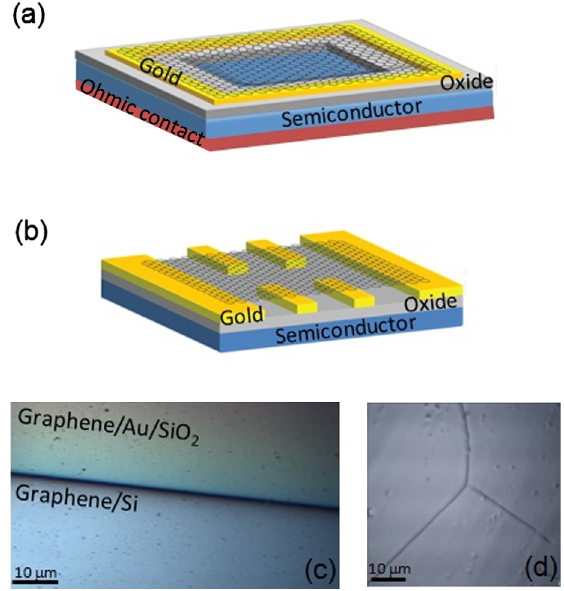
FIG. 1. (a) Graphene/semiconductor diode-sample geometry, where the J - V characteristics are measured between Ohmic contact (ground) and graphene (high). (b) Hall-bar geometry for measurements of the carrier density of graphene. In this configuration, the graphene does not make contact with the semiconductor. (c) Optical image of the graphene = Au = /graphene/Si transition edge after the graphene transfer. SiO 2 (d) Scanning-electron-microscope image of Cu foils after the graphene growth by CVD, showing the grain boundaries and formation of grain sizes that are large with respect to the 10 - (cid:1) m scale